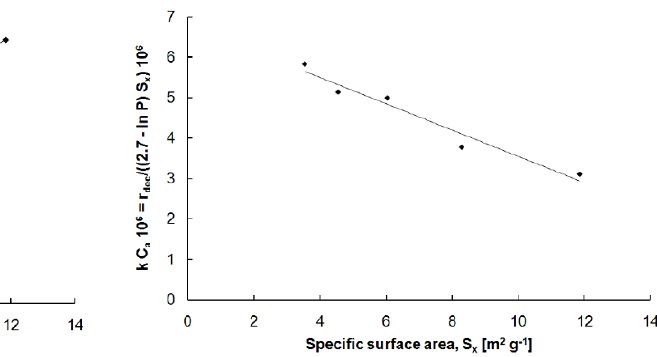
as a function of specific surface